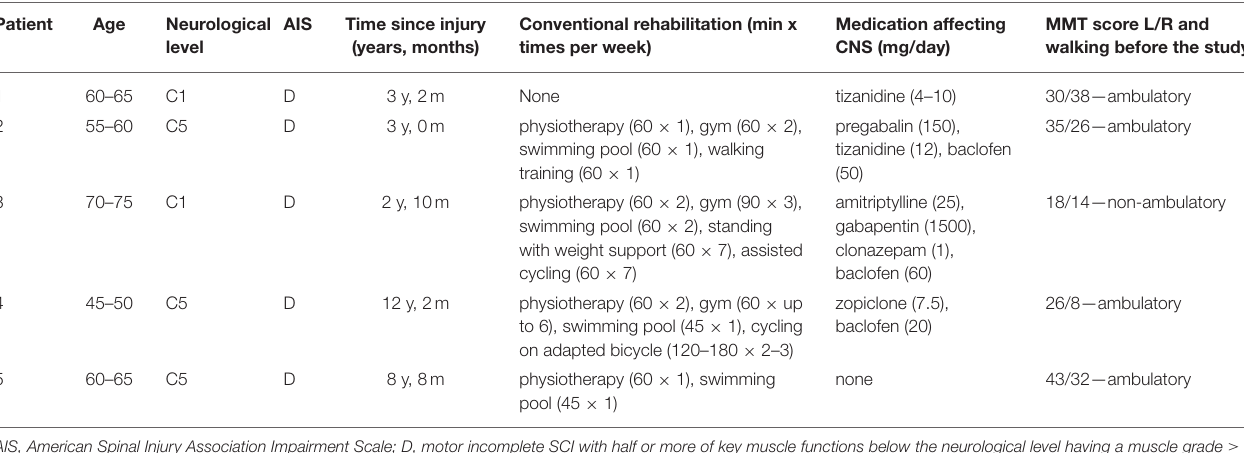
TABLE 1 | Patient characteristics.